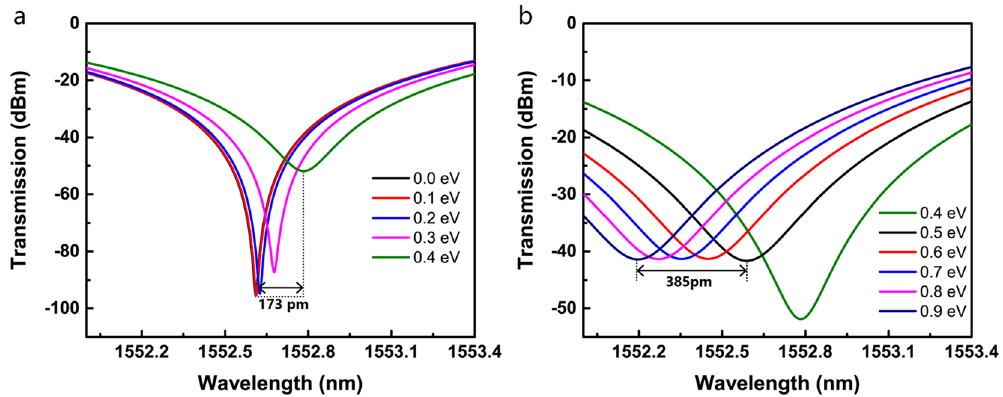
Figure 4. Transmission of modulator in ( a ) electro-absorption and ( b ) electro-refractive modes.